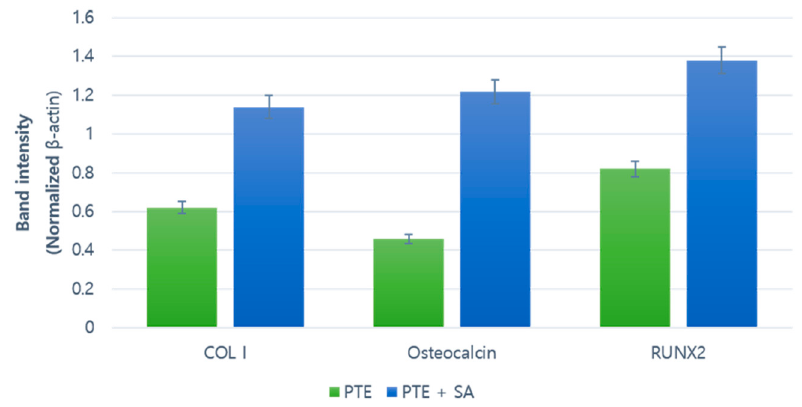
Figure 6. Western blot results of Runt-related transcription factor2 (Runx2), collagen type I (ColI), and Osteocalcin. A comparison of the protein analysis with electrophoresis at eight weeks postop- erative.